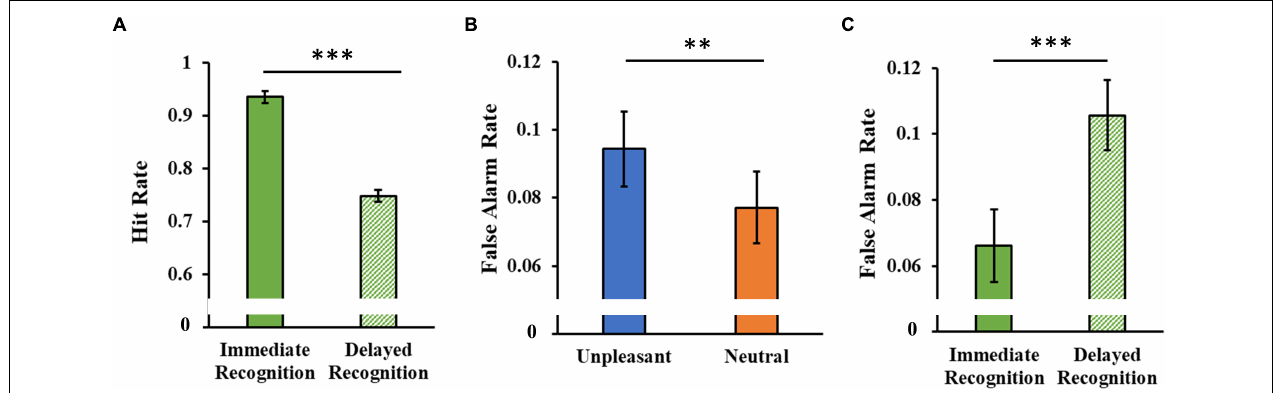
FIGURE 7 | (A) Hit rate as a function of the experimental session (immediate and delayed recognition sessions). (B) False alarm rate as a function of the type of stimuli (unpleasant and neutral pictures). (C) False alarm rate as a function of the experimental session (immediate and delayed recognition sessions). Error bars represent standard error of the mean. ∗∗ p < 0.01; ∗∗∗ p < 0.001.